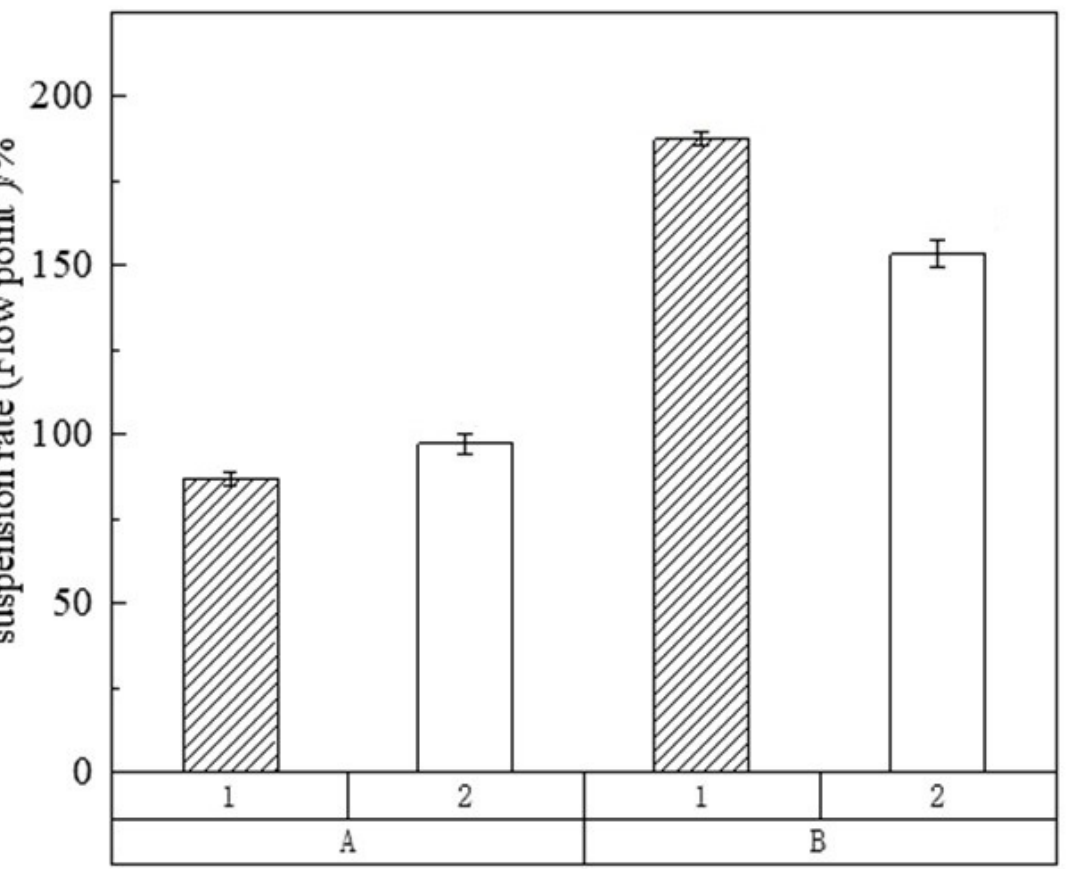
Figure 6. Suspension rate and flow point of APEG and the polysulfonate dispersant (A1 and B1 are suspension rate and flow point value of APEG; A2 and B2 are suspension rate and flow point value of the polysulfonate dispersant).